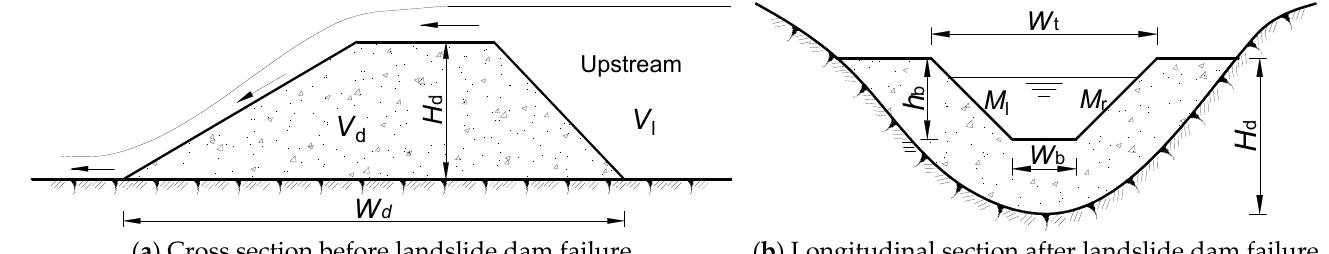
Figure 1. Schematic diagram of dam shape.